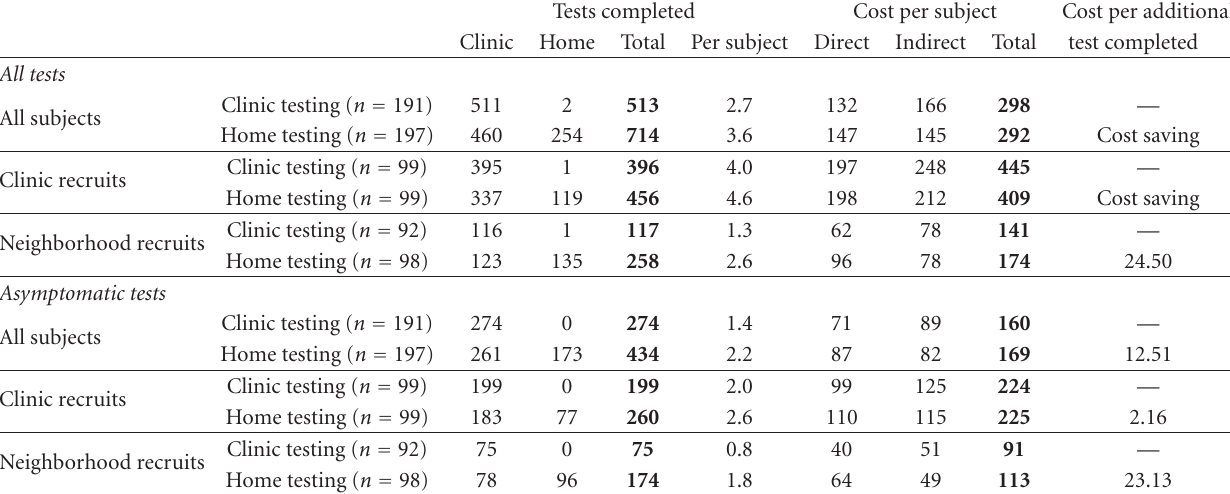
Table 3: Number of tests completed, testing costs, and cost-e ff ectiveness of the home screening intervention.